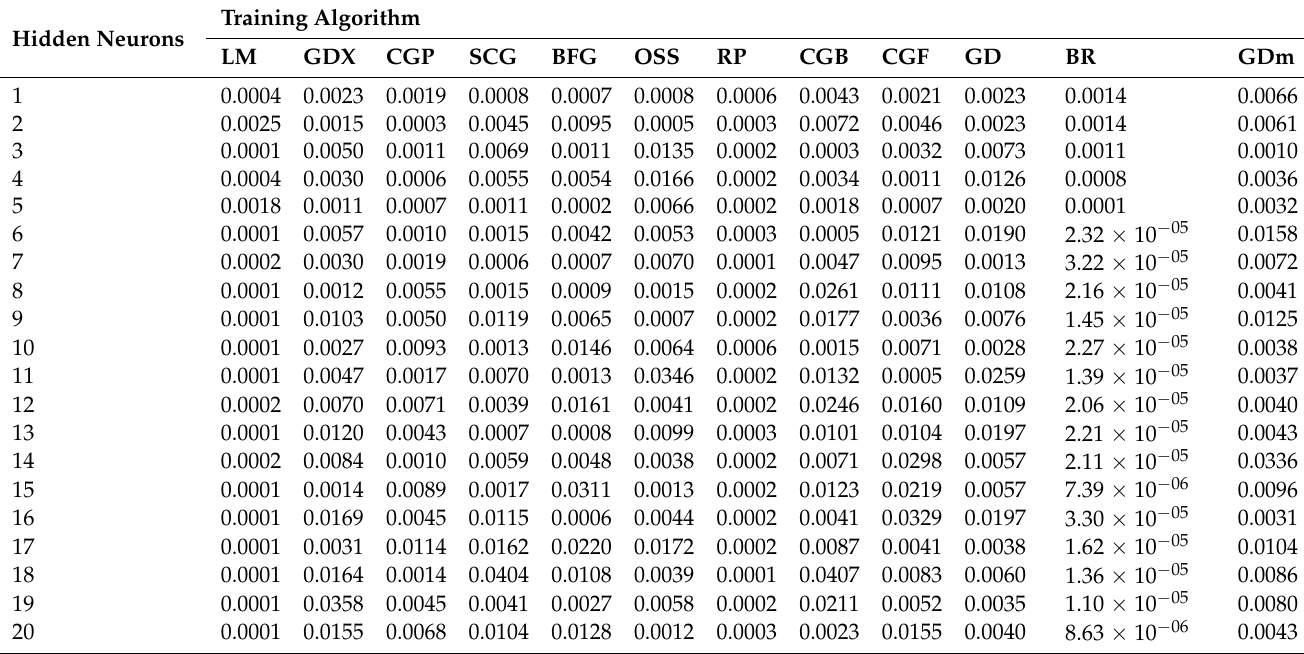
Table A18. MSE for methane yield for different training algorithms at different number of hidden